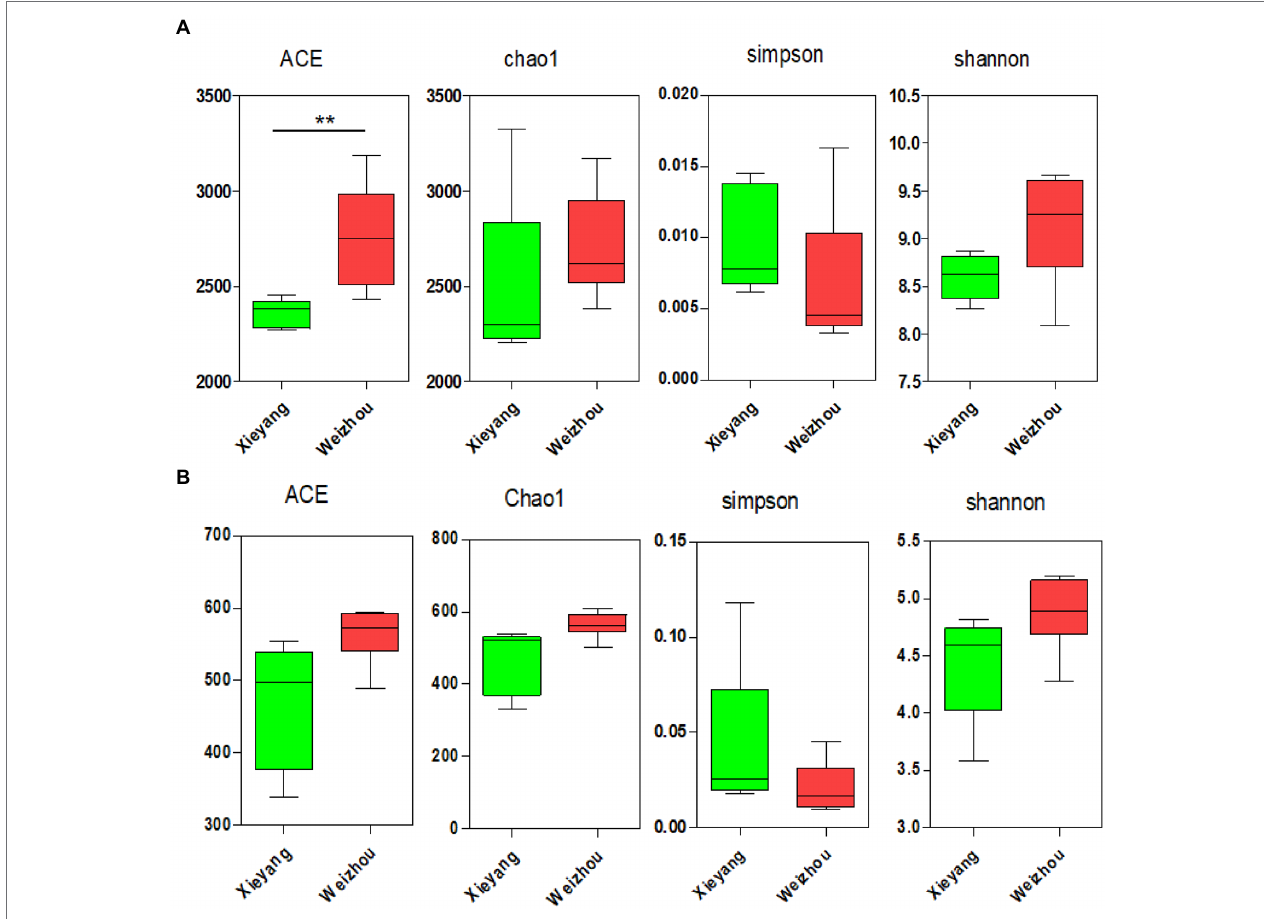
FIGURE 2 | The alpha diversity of bacterial and actinobacterial communities in Weizhou and Xieyang Islands is illustrated by ACE, Chao1, Shannon’s, and Simpson’s diversity indices. (A) The alpha diversity of the overall bacterial communities; (B) the alpha diversity of the actinobacterial communities on Weizhou and Xieyang Islands. Asterisks indicate the significance of the ANOVA results (** p <